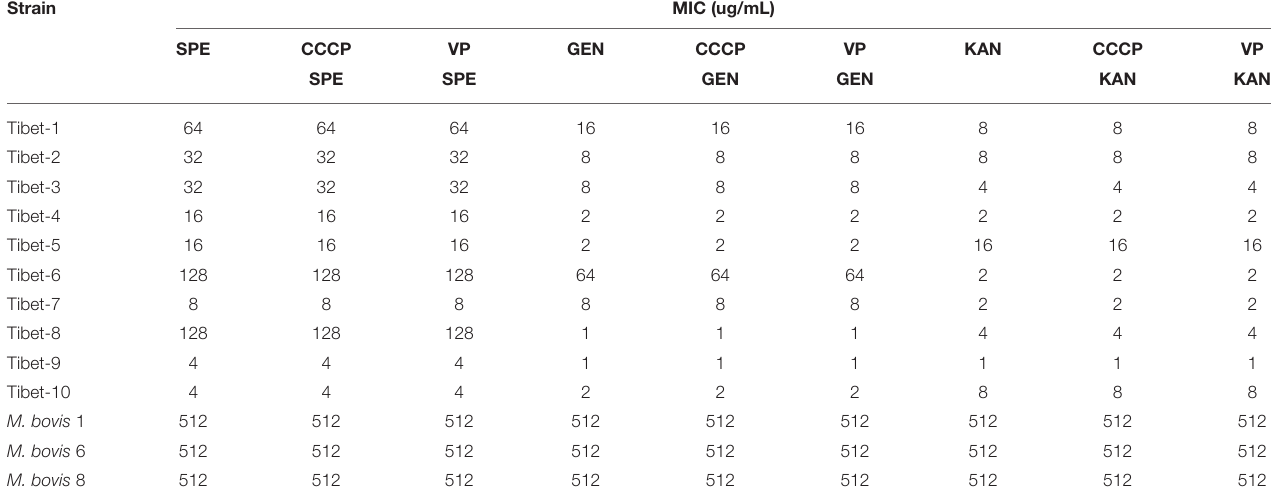
TABLE 8 | The MIC effects of aminoglycosides by using CCCP and